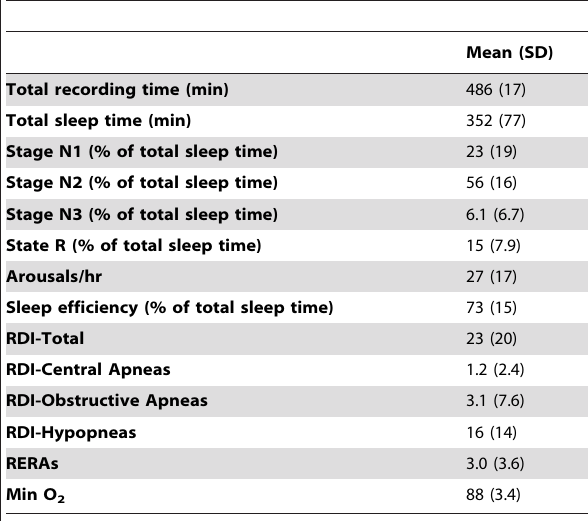
Table 2. Mean (SD) of sleep parameters and the number of events on the Respiratory Disturbance